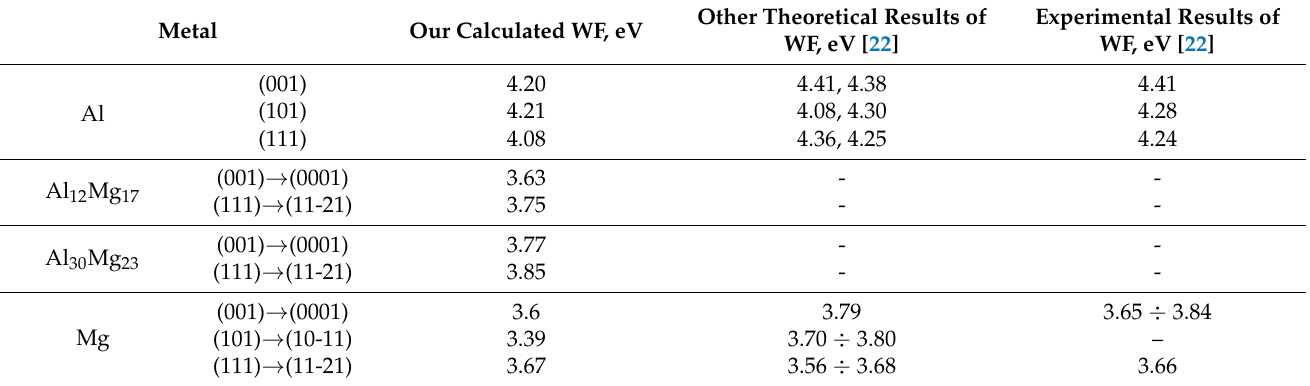
Table 3. The values of the electron WFs of the Al, Mg and Al 12 Mg 17 and Al 30 Mg 23 intermetallic phases calculated via the DFT method.